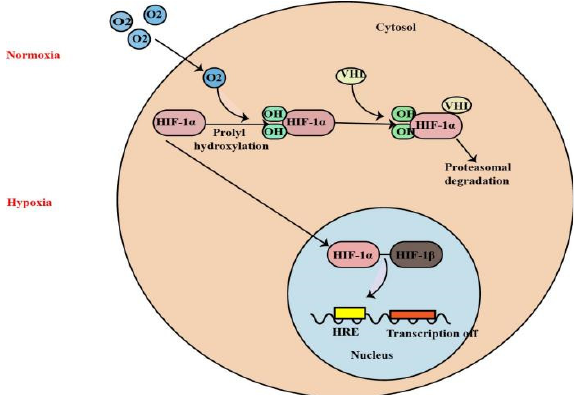
Figure 1. Under normoxia, HIF-1 α is rapidly degraded when it is hydroxylated at two proline residues within the oxygen-dependent degradation domain by prolyl hydroxylase domain (PHD) proteins. It is subsequently ubiquitinated by the E3 ubiquitin ligase activity of the von Hippel-Lindau tumor suppressor protein (pVHL), thereby targeting HIF-1 α for degradation by the proteasome. Under hypoxia, HIF-1 α transfers to the nucleus and heterodimerizes with HIF-1 β . The HIF-1 dimer subsequently binds to the hypoxia-response element sites on the DNA to initiate the expression of more than 100 genes involved in hypoxia adaptation.